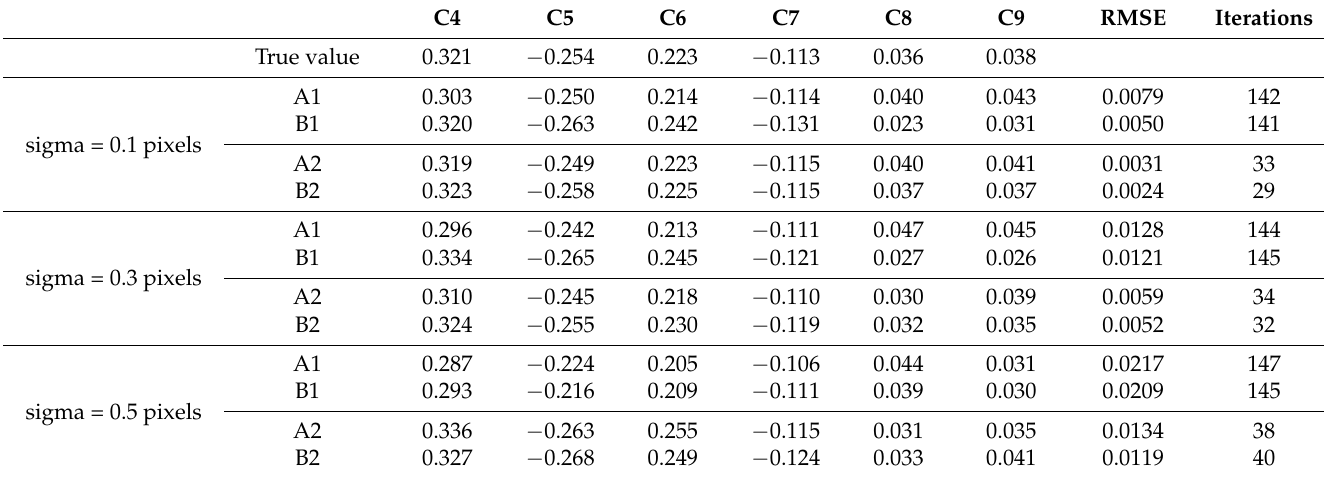
Table 1. Comparison of traditional phase retrieval algorithms which do not take jitter into consid- eration (A1, B1) and the two jitter-robust phase retrieval approaches (A2, B2) for the PSF pairs in Figure 3.